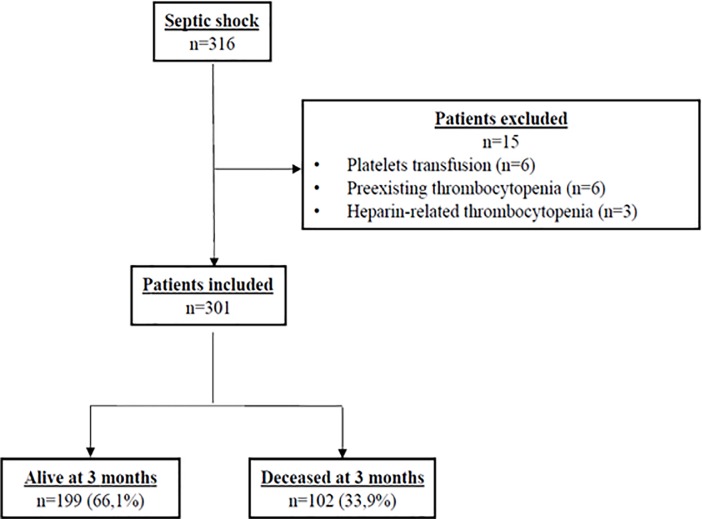
Flowchart of the enrolment of the patients in the study.